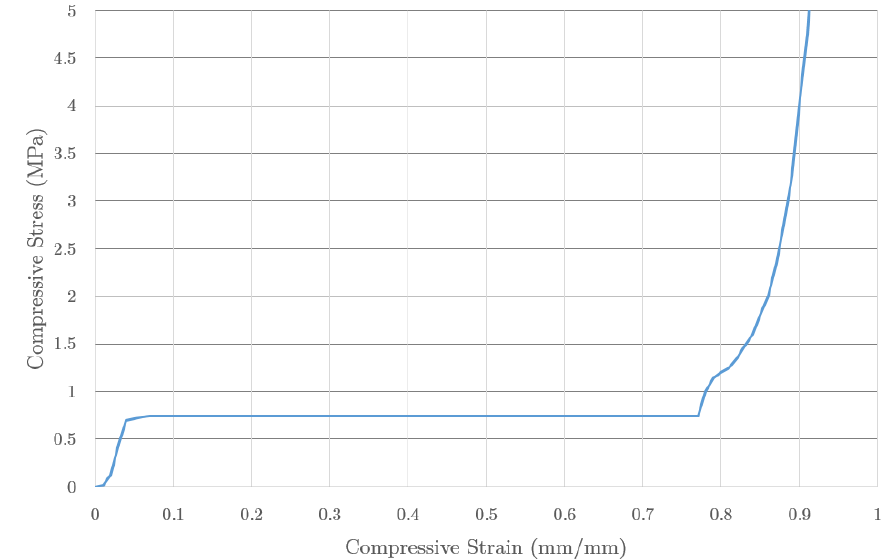
Figure 8. Values of stress (MPa) as function of the strain for a compressive test of IMPAXX500 TM material, as given by the producer. The properties of the foam were defined as a crushable Ls-Dyna foam type, and the measured data were input into the